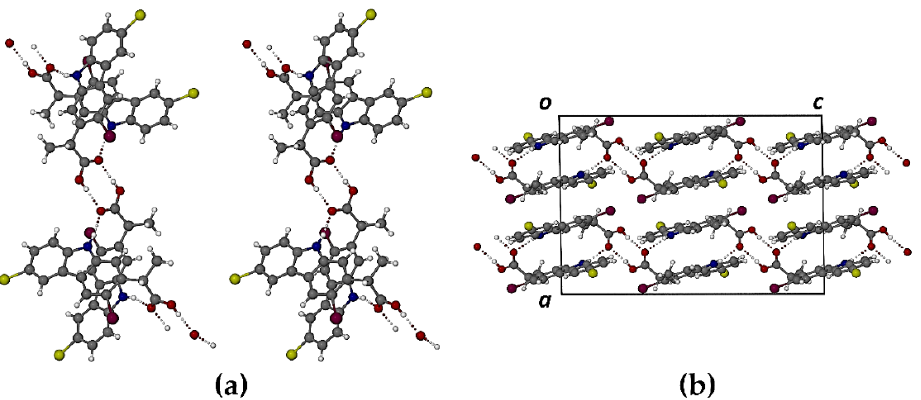
Figure 3. A stereoview of the repeating supramolecular motif in the crystal of 2 propagating parallel to the crystal c-axis ( a ), and the crystal packing shown in the [010] projection ( b ). Dotted lines rep- resent hydrogen bonds.